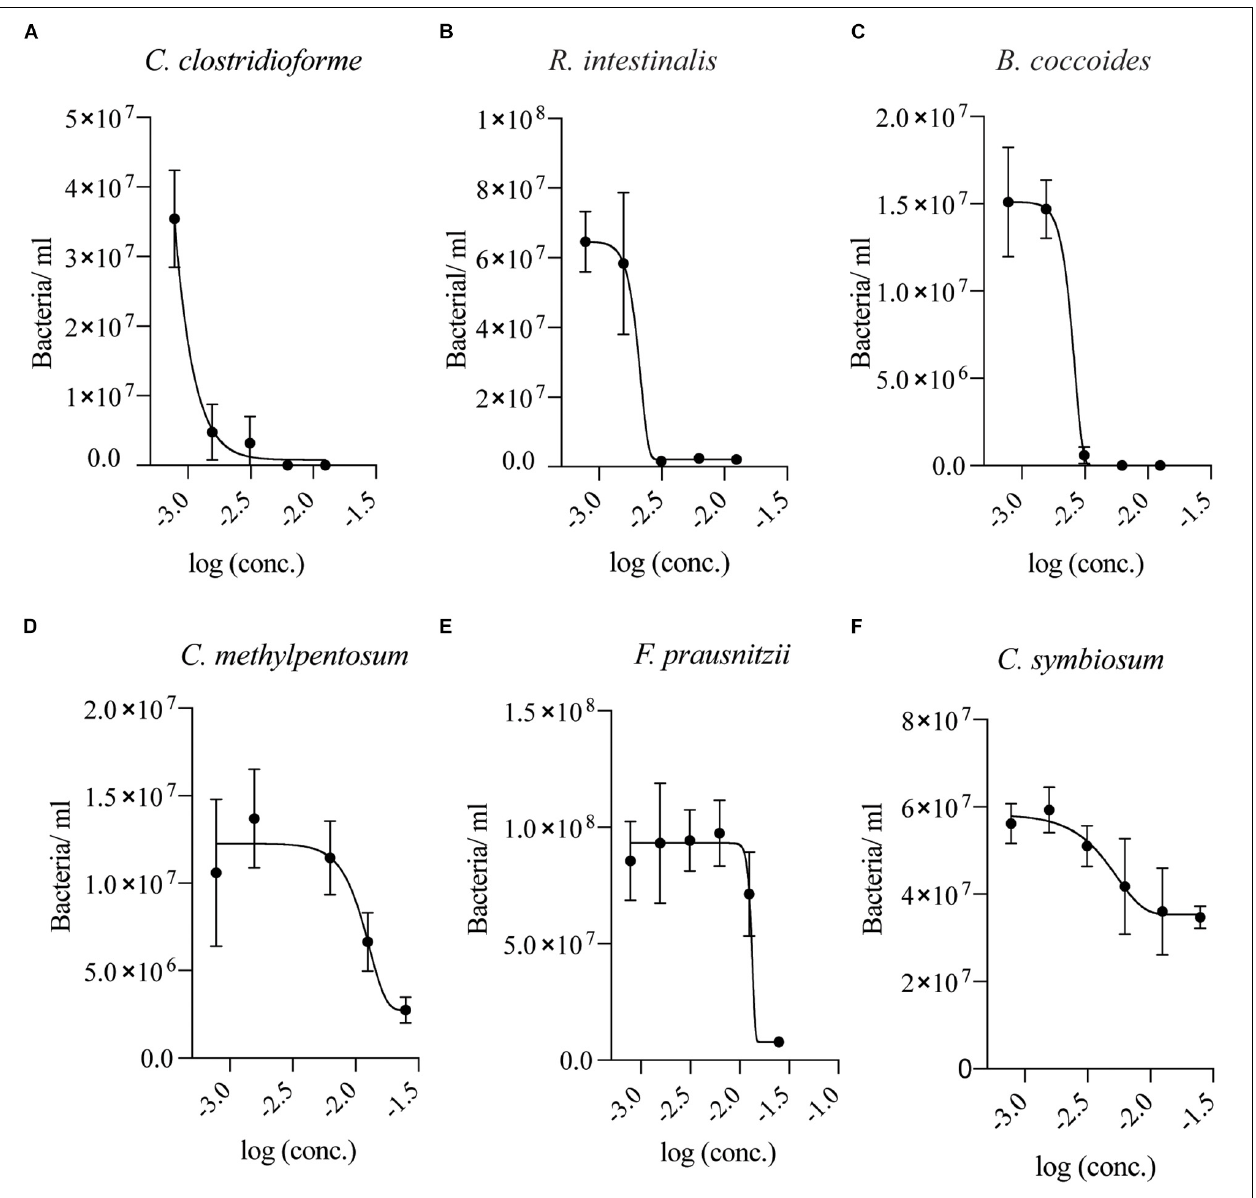
FIGURE 3 | Low concentrations of SSL inhibits Clostridial species. Growth of (A) C. clostridioforme, (B,C) R. intestinalis and B. coccoides, and (D) C. methylpentosum growth was suppressed at SSL concentrations > 0.0015% (log –2.8), > 0.003% (log –2.5), and > 0.01% (log –2) (w/v), respectively. (E) F. prausnitzii was inhibited at concentrations > 0.013% (log –1.9) (w/v) SSL. (F) C. symbiosum had the lowest sensitivity of the tested bacteria and grew at 0.025% but growth was suppressed ( n = 18, three biological